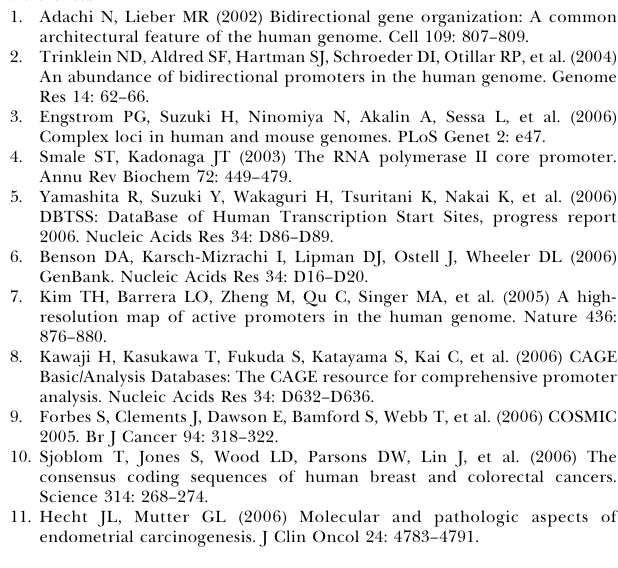
Figure S3. Relationships between Co-Expression Clusters Produced from MDS